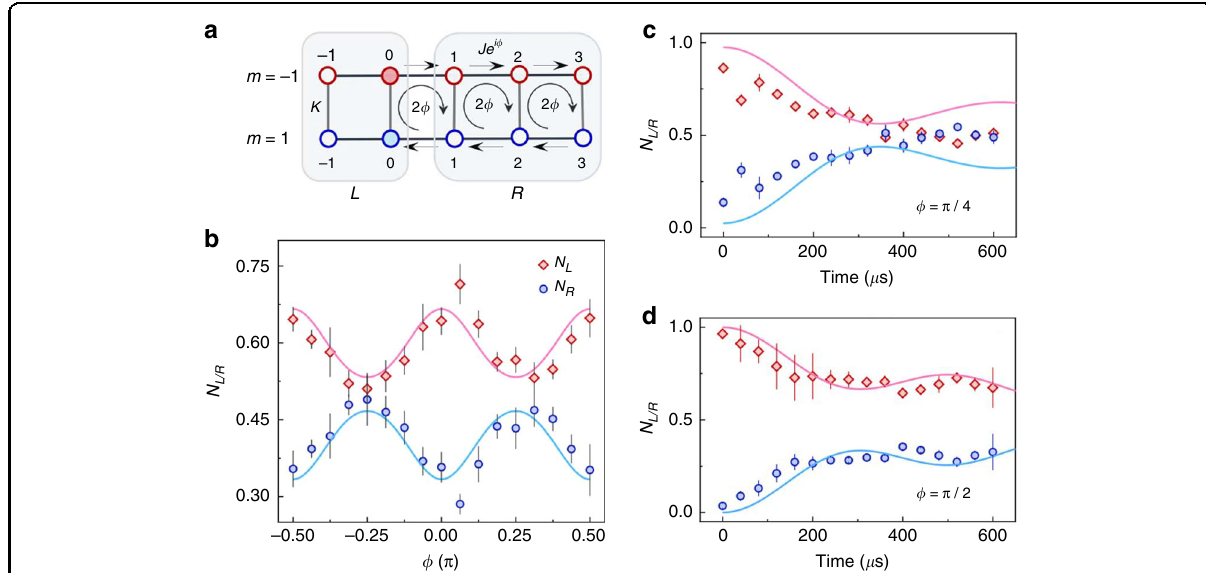
Fig. 5 Atomic transport in an inhomogeneous arti fi cial magnetic fi eld. a Schematic of the two-leg ladder with an inhomogeneous arti fi cial magnetic fi eld produced by applying a step-changing gauge fl ux. The ladder is divided into two parts, in which the leftmost plaquette (rightmost two plaquettes) with zero (nonzero) fl ux is referred as the left (right) cell. b The population of atoms in the left and right cells ( N L and N R ) as a function of the gauge phase ϕ after an evolution time of t = 320 µ s. Time evolution of N L and N R for ( c ) ϕ = π /4 and ( d ) ϕ = π /2. Solid lines are theoretical curves from numerical simulation of noninteracting tight-binding